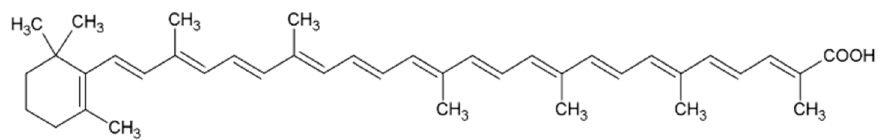
Figure 5. The structural formula of torularhodin.